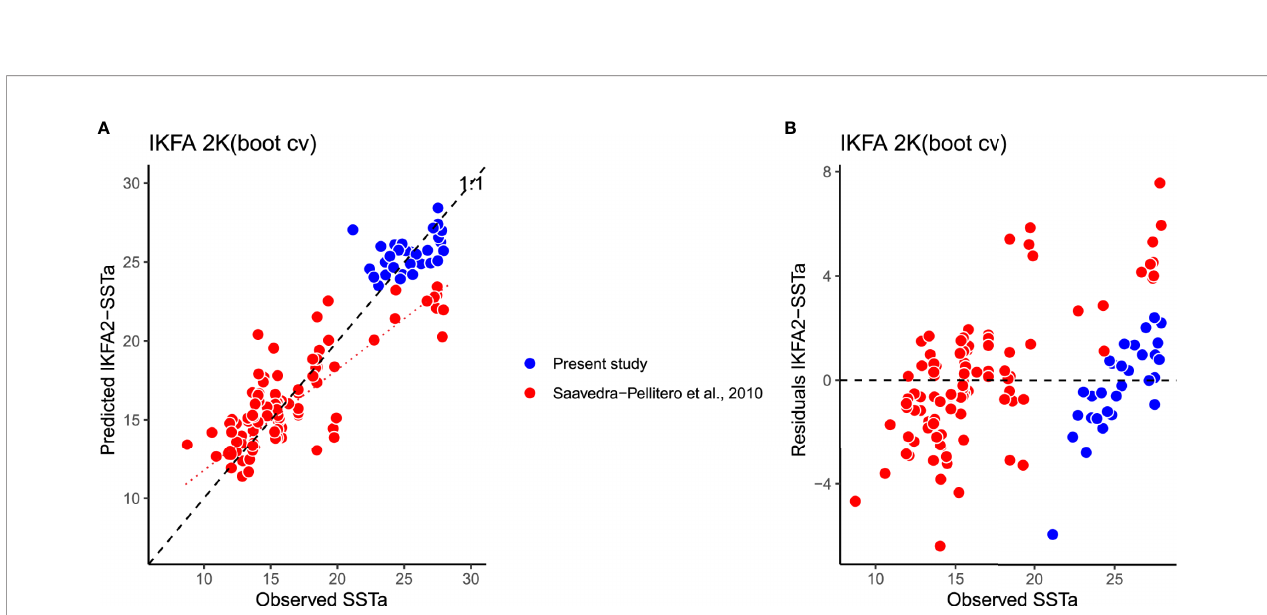
FIGURE 6 | (A) Observed versus Predicted annual SSTa at 10 m using coccolith assemblages from the surface sediments in samples from Saavedra-Pellitero et al. (2010) (red) and the present study (blue), using a Imbrie-Kipp factor analysis (IKFA) with 2 factors, under bootstrapping cross-validation (999 iterations). (B) Residual versus Observed annual SSTa at 10 m. Dashed line in (A) indicates the regression line between all the observed vs predicted SSTs, and dotted line just considering Saavedra-Pellitero et al.